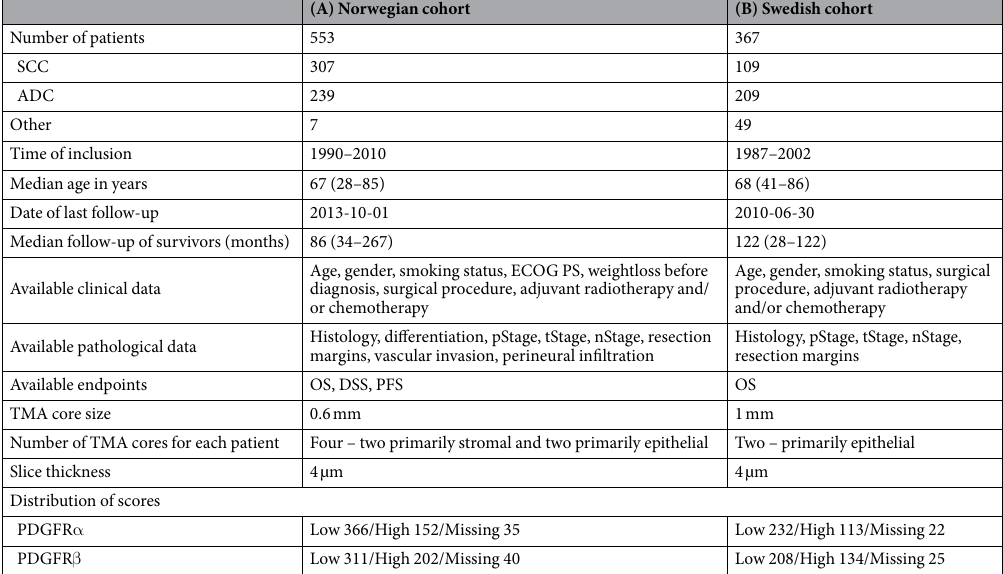
Table 1. Summary and comparison of clincopathological and technical characteristics for (A) The Norwegian cohort and (B) The Swedish cohort. Abbreviations: SCC, squamous cell carcinoma; ADC, adenocarcinoma; TMA, tissue micro-array; PDGFR, platelet-derived growth factor receptor; OS, overall survival; DSS, disease- specific survival; PFS, progression-free